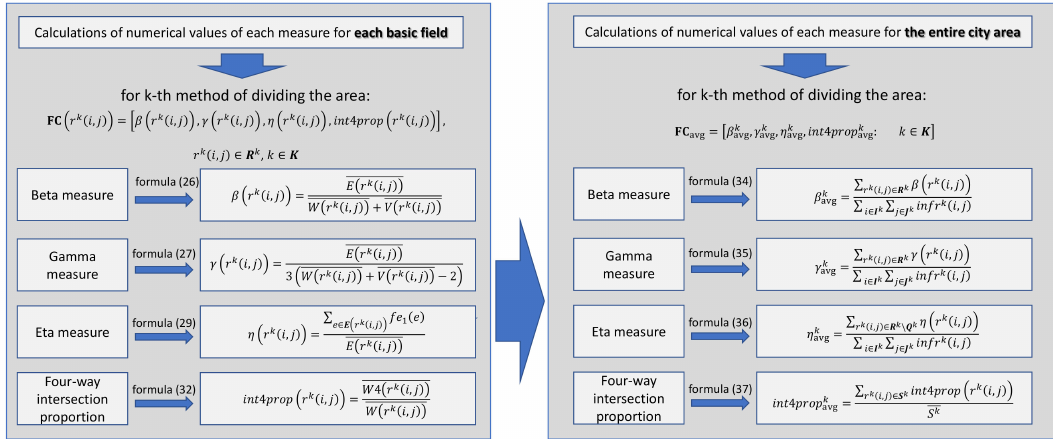
Figure 4. The scheme of the calculation process of the assessment of the connectivity of the road and street network with selected